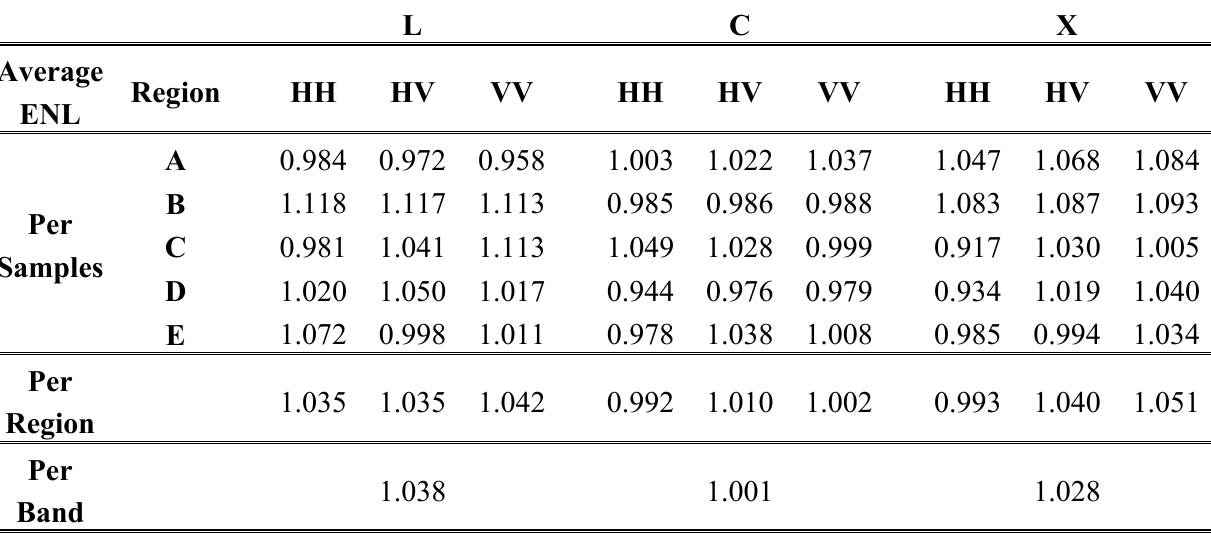
Table 3. Estimated Equivalent Number of Looks ( ENL